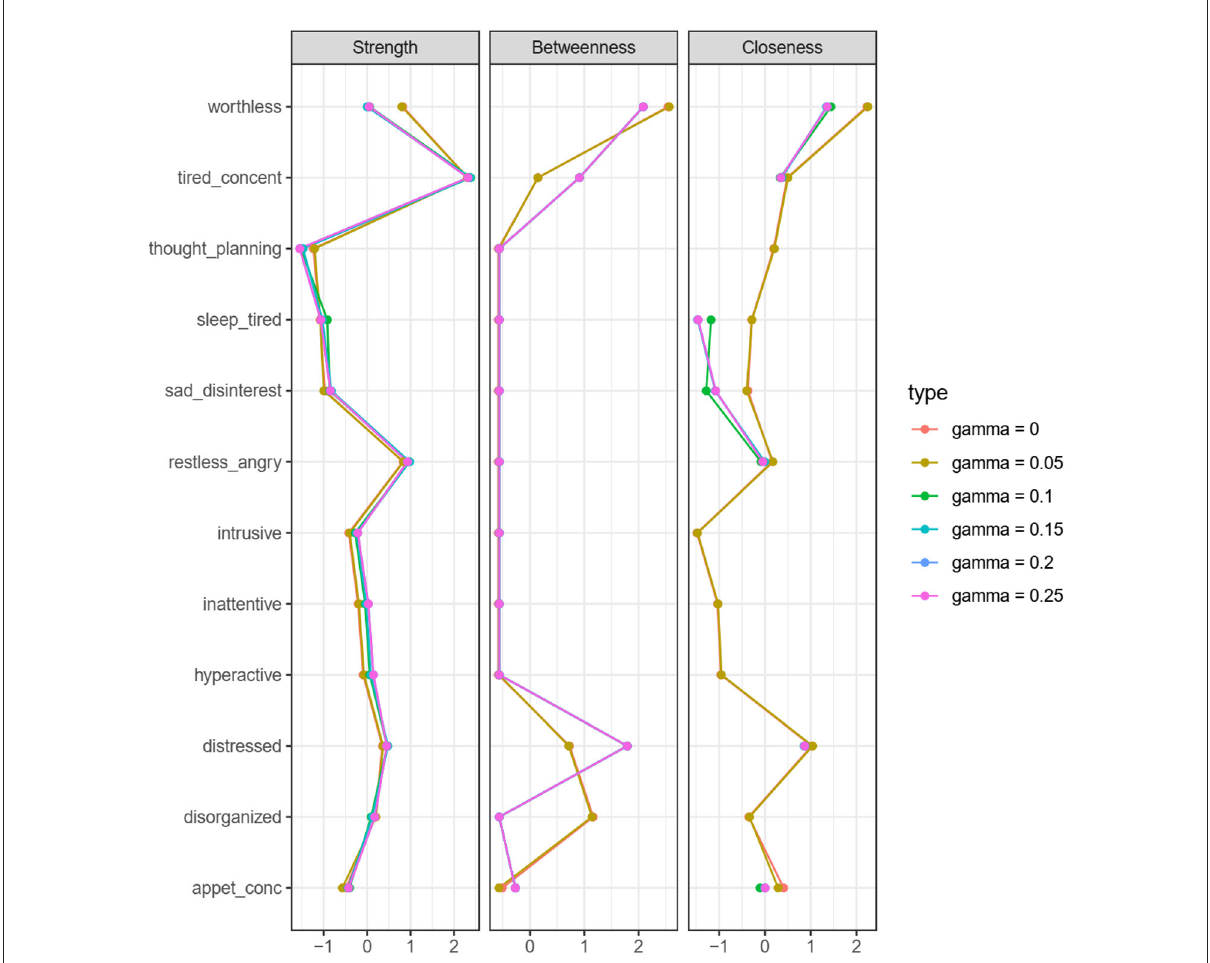
FIGURE6 Robustness check—Comparisons of networks with different hyperparameters by three centrality